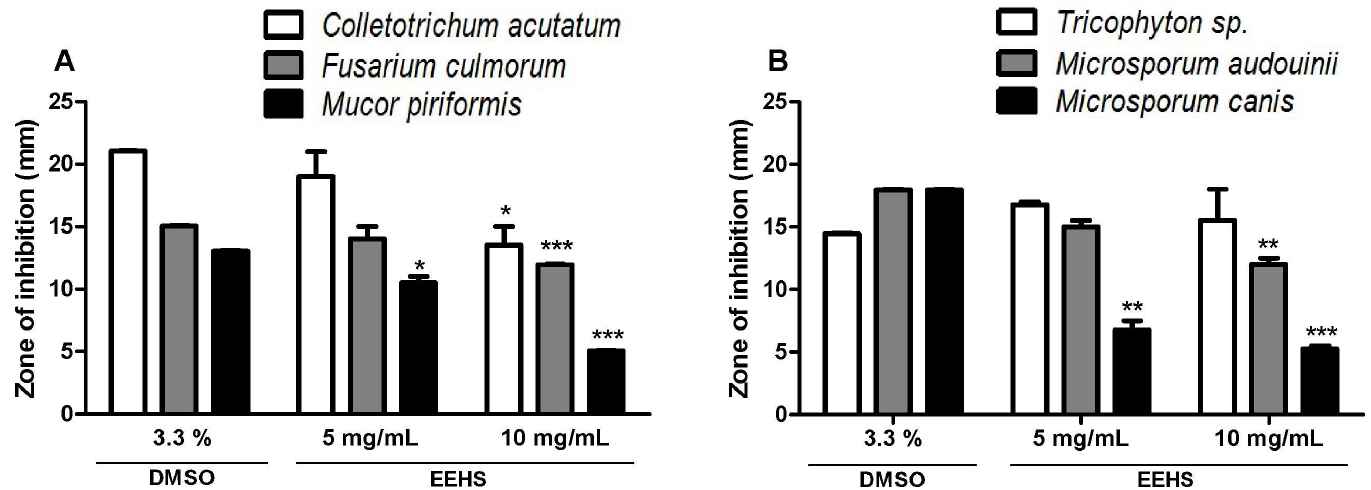
Fig 4. Zone of inhibition of filamentous fungi. Growth inhibitionby the EEHS (5 mg/mL and 10 mg/mL) in the (A) filamentous fungal species Colletotrichum acutatum ESA12, Fusarium culmorum ESA23, and Mucor piriformis ESA43 and (B) dermatophytes Microsporum canis ESA28, Microsporum audouinii , and Trichophyton sp. (in mm). Valuesare expressed as the mean ± SEM of duplicateexperiments. * P < 0.05, ** P < 0.01, and *** P < 0.001 when the treated groups were comparedwith the control group (3.3%